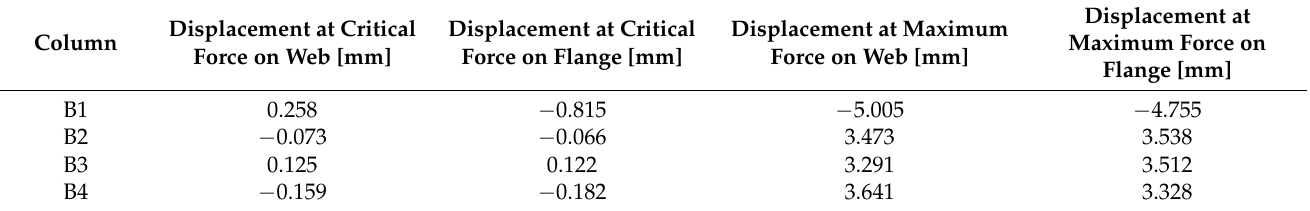
Table 6. Displacement values for flange and web measurement points obtained using the optical